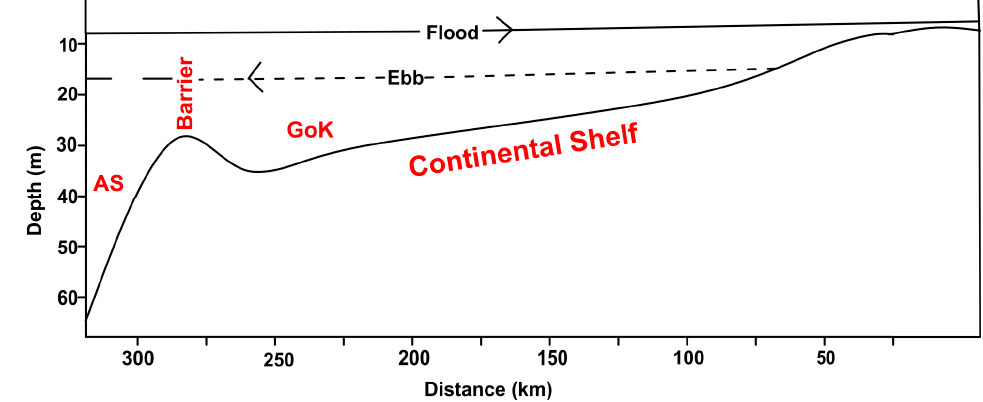
Figure 14. Schematic figure showing the formation of the barrier due to the combined action of bathymetry and tide, where water enters the Gulf due to high flood current speed but the barrier restricts the water exit during ebb.